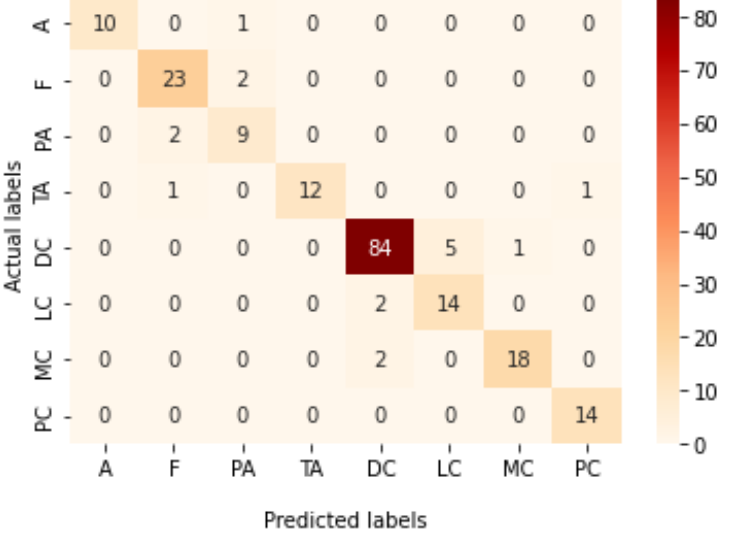
Figure 28. Confusion matrix of Xception model in 200 × magnification-dependent multi-classification.